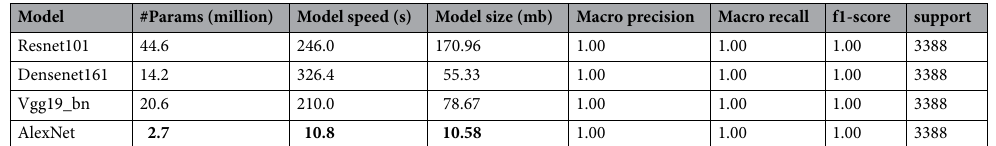
Table 1. Comparison of model size, speed, and performances of each studied model (The text in bold indicates the best value in each category).